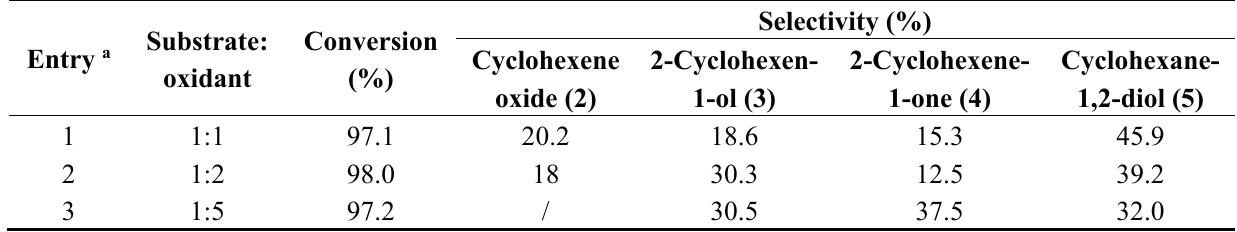
Table 4. The selective oxidation of cyclohexene to 1,2-diols catalyzed by iron (III) phthalocyanines with triflate as a counter anion using H 2 O 2 as an oxidant at different condition.